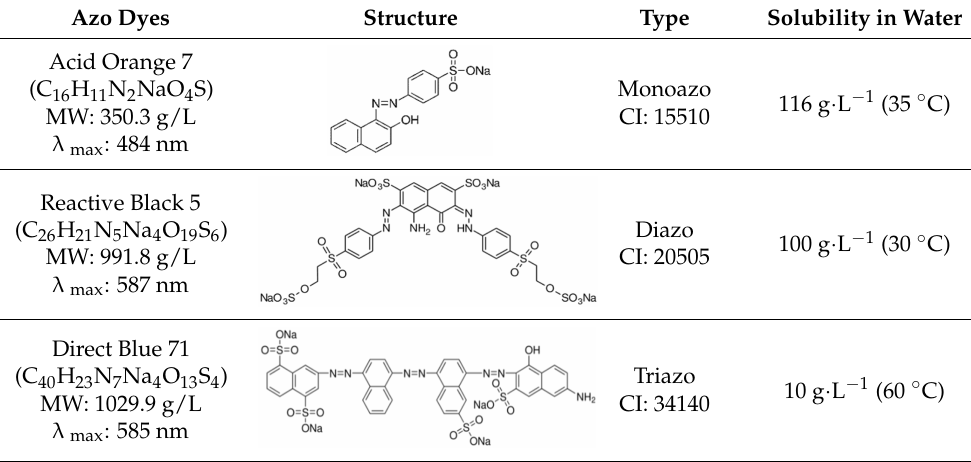
Table 1. Structure, composition, and properties of selected azo